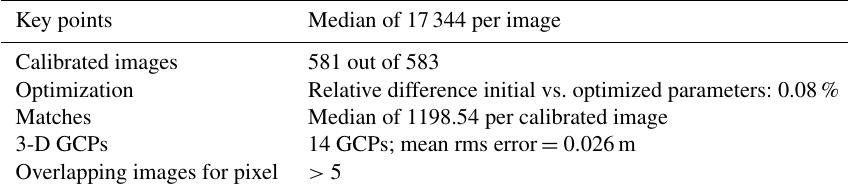
Figure 5. Sequence of processing steps used in the photogrammetric workflow of UAV images. Main details of each step are given in the dashed boxes. Table 1. Pix4D report